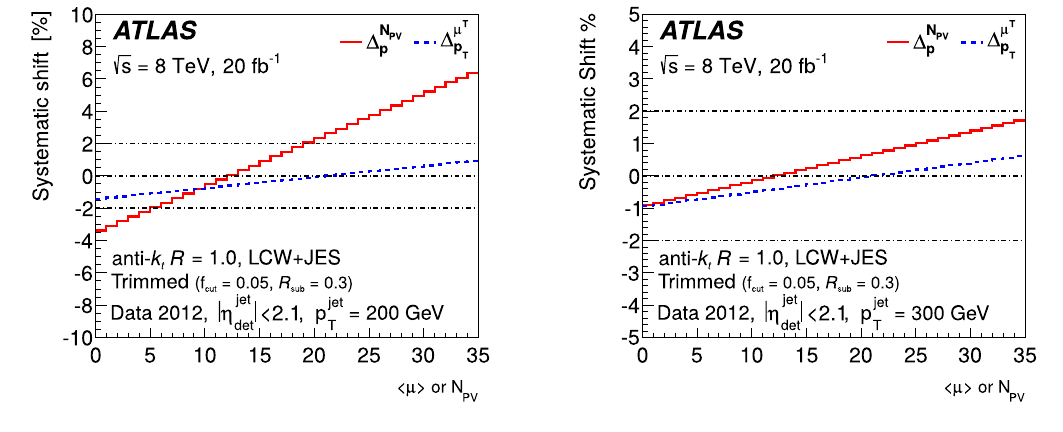
Fig. 33 Systematic uncertainties due to the N PV and μ dependence of the large- R jet p T presented in percentage as functions of μ (dashed lines) and N PV (solid lines) for large- R jets with a p T = 200 GeV and b p T = 300 GeV. Horizontal lines are added at 0% and ± 2% to guide the